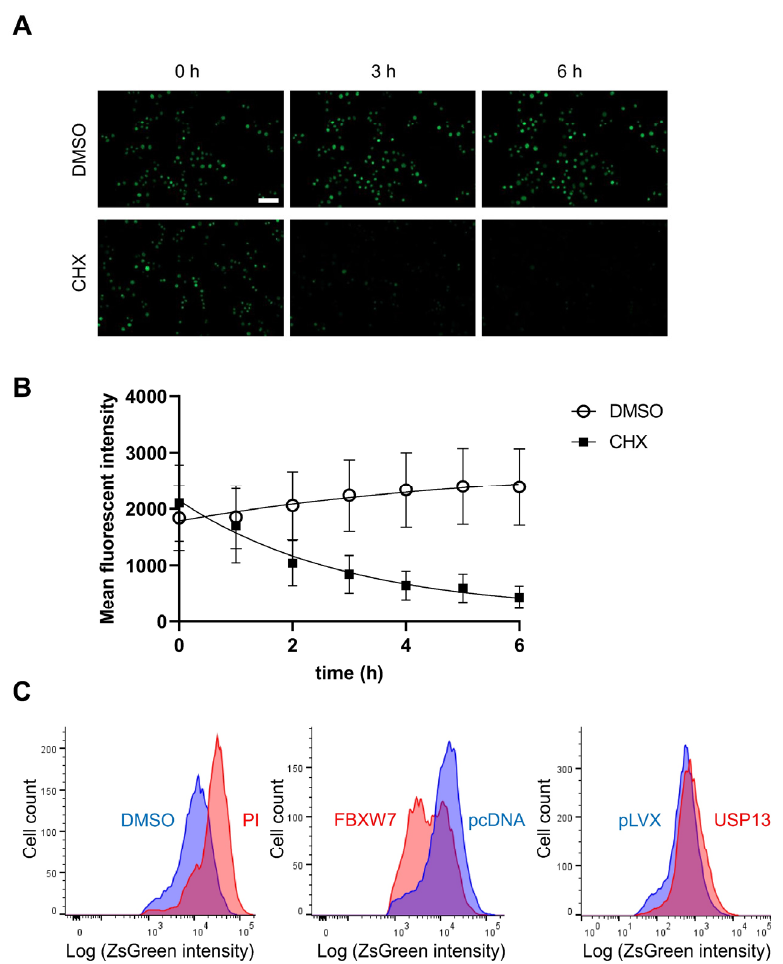
Figure 2. Proteolytic characterization of the ZsGreen1-c-MYC fusion protein. ( A ) Clonal HeLa cells that stably expressed ZsGreen1-c-MYC were analyzed for green fluorescence in the presence of solvent control (DMSO, 0.1% vol.) or equal volumes of the translation inhibitor Cycloheximide (CHX, 10 µ g/mL). Scale bar represents 100 µ m. ( B ) c-MYC is a short-lived protein. Similarly, the fluorescent fusion protein was also rapidly degraded with a half-life of 2.04 h based on quantification of epifluorescence microscopy. Data points denote mean values, error bars represent the standard deviations. The graph was modeled based on one-phase exponential decay (GraphPad Prism 9.2). The decay rate constant was calculated as 0.3402 (1/h). ( C ) FACS quantification of stable ZsGreen1-c-MYC reporter cells following 6 h treatment with proteasome inhibitor (PI) lactacystin (12.5 µ M) compared to equal volume of solvent control DMSO, or following 48 h transfection with the ubiquitin ligase component FBXW7 (compared to empty vector pcDNA3), which accelerated removal of the fusion protein, or deubiquitinating enzyme USP13 (compared to empty vector pLVX), which reduced turnover of the c-MYC construct. The flow cytometry histogram x axis represents the logarithmic ZsGreen1 intensity, the y axis indicates cell counts. Shown is a representative of three biological replicates, with statistically significant differences ( p < 10 − 6 , Wilcoxon rank-sum test with Bonferroni correction after analysis of 10,000 cells).